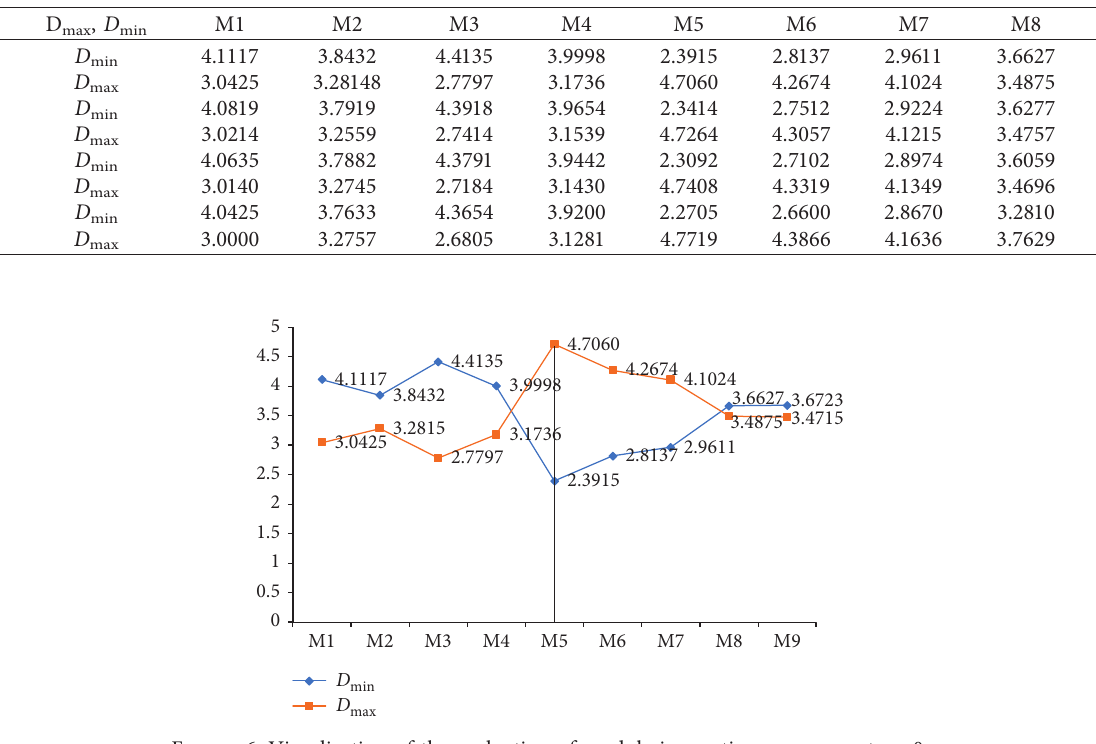
Table 3: Evaluation of module innovation resources using the distance measurement